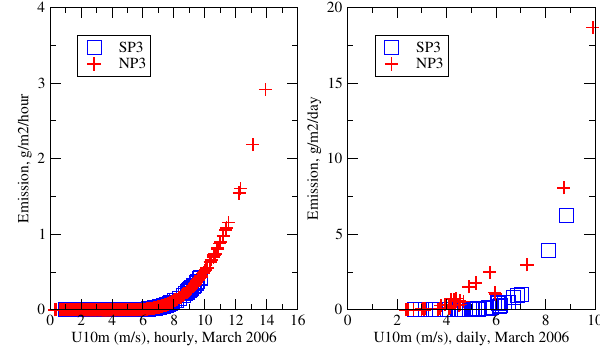
Figure 2. Scatter plot of the emission vs. 10m wind speed (ms − 1 ) for simulations SP3 (blue) and NP3 (red) for March 2006, at 7.5 ◦ W, 18.5 ◦ N (location shown in red in Fig. 1). The left panel corresponds to an hourly sampling of instantaneous values (with emission given in gm − 2 h − 1 ) while the right panel shows daily averages (with emissions given in gm − 2 day − 1 ).